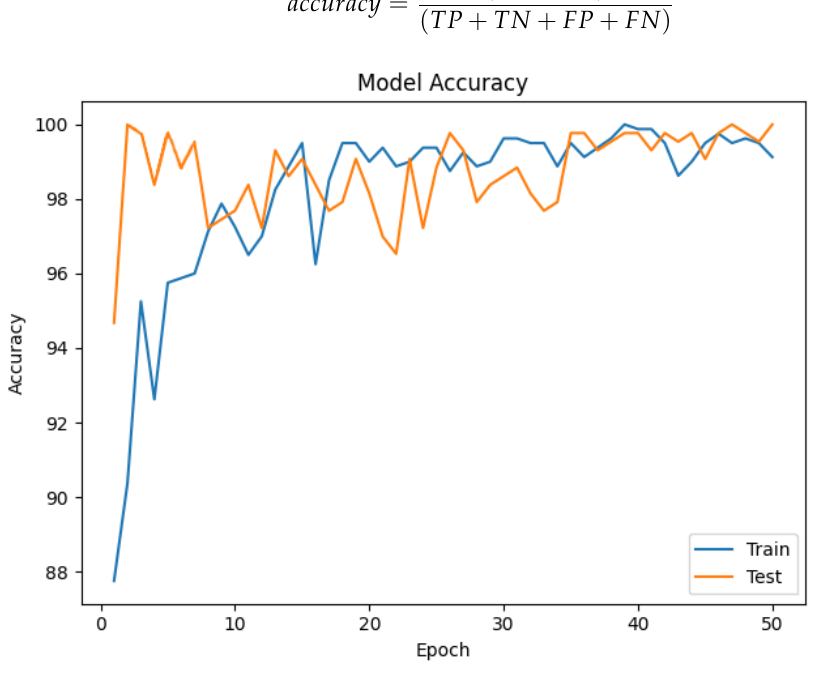
Figure 7. Model accuracy of UPS +